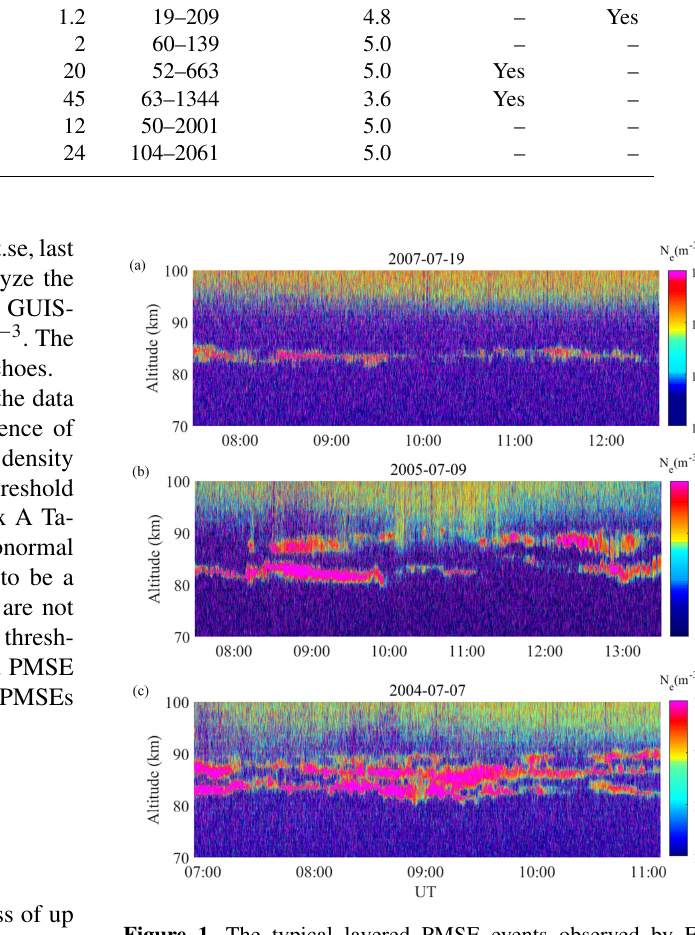
Figure 1. The typical layered PMSE events observed by EIS- CAT 224MHz VHF radar. (a) Monolayer PMSE. (b) Double-layer PMSE. (c) Tri-layer